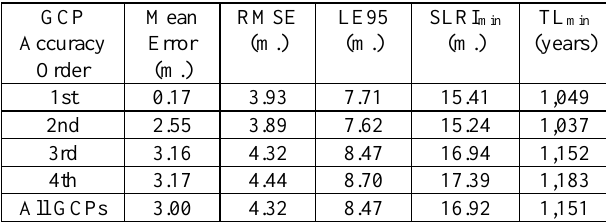
Table 7. Values of parameters related to the vertical uncertainties of the ASTER GDEM 2 computed based on the order of GCP accuracy.